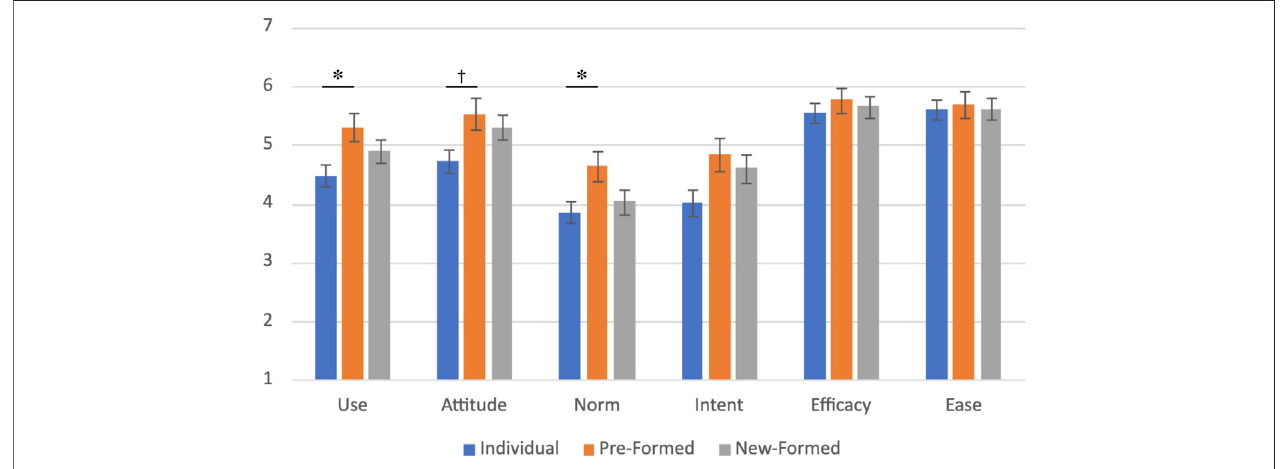
FIGURE 8 | A description of the results from H3. Asterisks indicate that participants who imagined pre-formed groups had more positive perceptions of the robot than participants who imagined being individuals. Crosses indicate when the ANOVA had signi fi cance, and the posthoc test p -value was < 0.1.